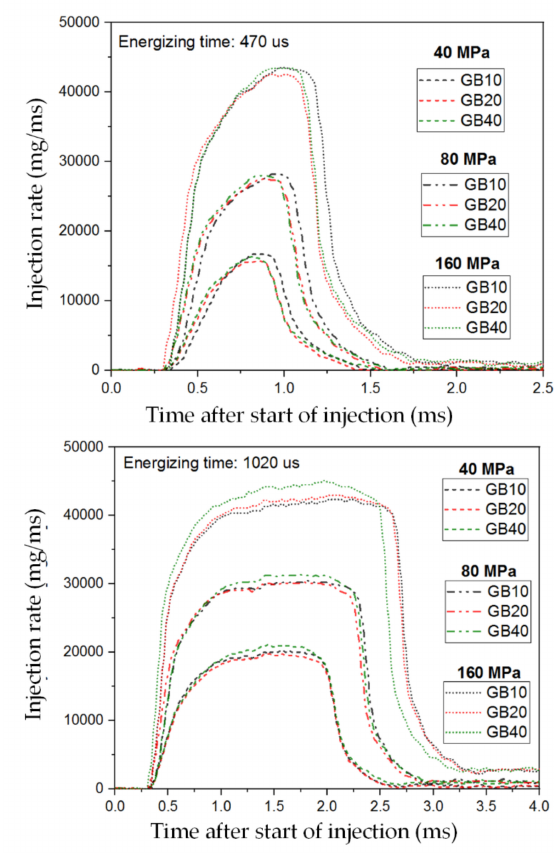
Figure 11. The injection rates of the fuels under injection pressures of 40, 80, and 160 MPa, upper figure: Energizing time 470us, lower figure: Energizing time 1020us (GB00: gasoline 100% and biodiesel 0%, GB05: gasoline 95% and biodiesel 5%, GB20: gasoline 80% and biodiesel 20%, GB40: gasoline 60% and biodiesel